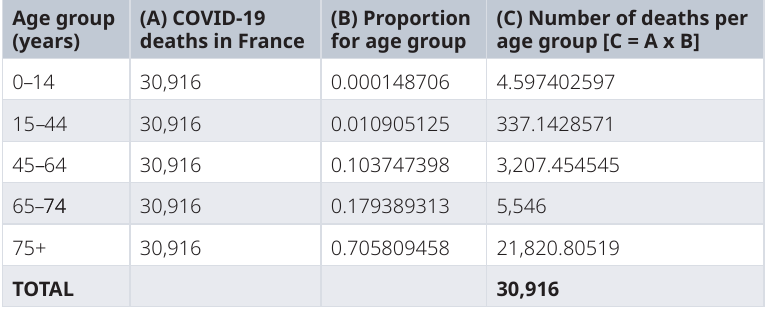
Table 6. Cumulative number of COVID-19 deaths per age group in France by 14 September 2020.